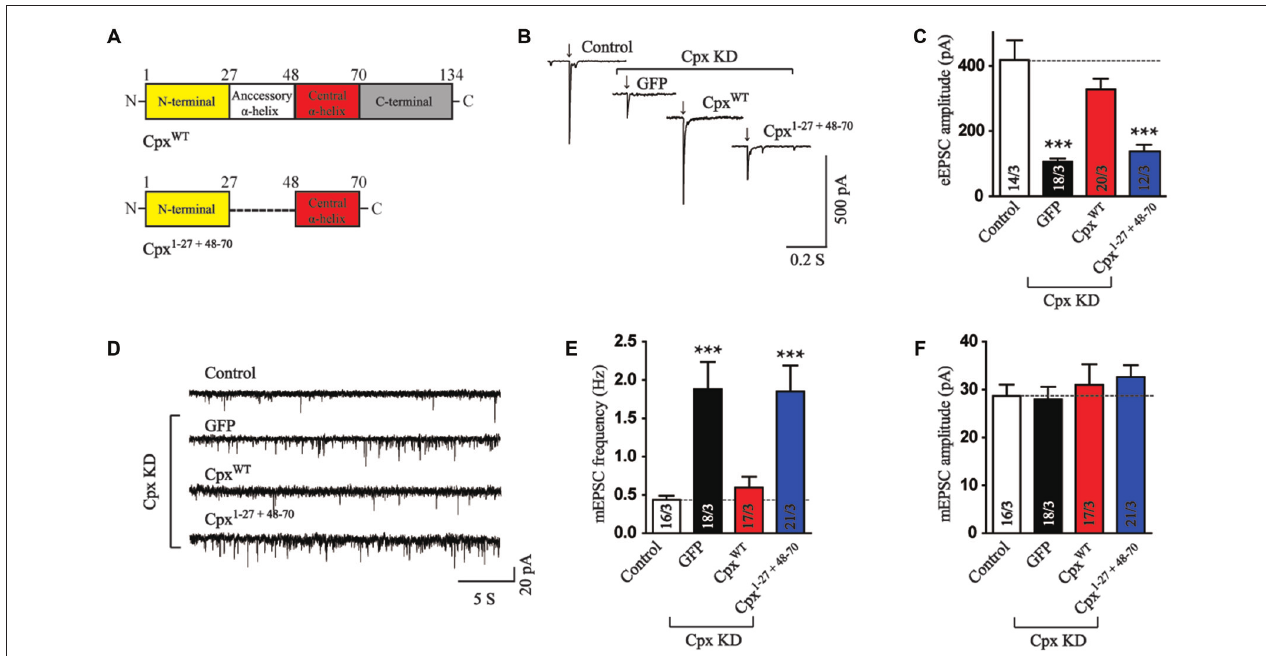
FIGURE 2 | The N-terminal domain is not sufficient to help central α -helix in exocytosis regulation. (A) Domain structures of wild type (Cpx WT ) and the N-terminal domain flanked with central α -helix of Cpx (Cpx 1–27 + 48–70 ). (B,C) Sample traces (B) and summary graphs of the amplitude (C) of action-potential evoked AMPAR-mediated EPSCs recorded in cultured cortical neurons that were infected with a control lentivirus (control) or lentiviruses expressing complexin shRNAs (GFP) without or with coexpression of Cpx WT or Cpx 1–27 + 48–70 , respectively. (D–F) Sample trace (D) and summary graphs of the frequency (E) and amplitude (F) of mEPSCs monitored in neurons as described for (B) . Data shown in summary graphs are means ± SEM; numbers of cells/independent cultures analyzed are listed in the bars. Statistical assessments were performed by the Student’s t -test comparing each condition to the indicated control experiment ( ∗∗∗ p <